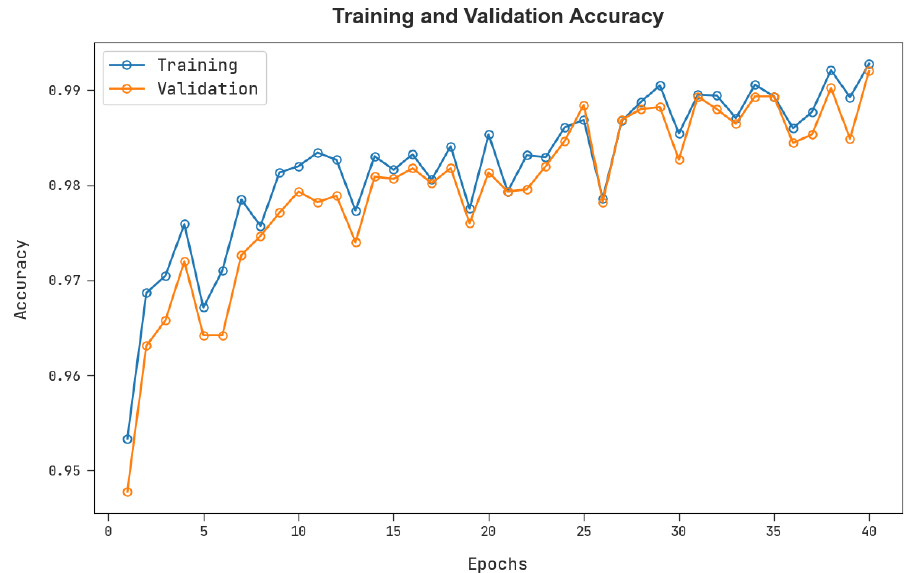
Figure 5. 𝑇𝑅 𝑎𝑐𝑐 and 𝑉𝐿 𝑎𝑐𝑐 analysis of AOEDBC-DL system.